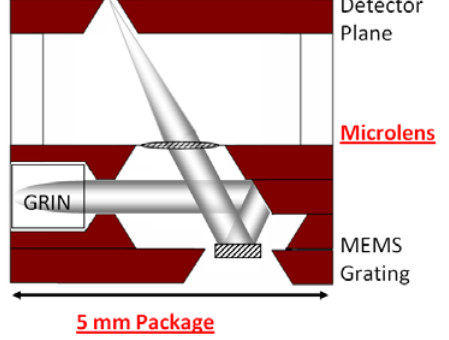
Figure 1. Cross-sectional view of the microspectrometer, showing the 5 mm silicon packaging with microlens, the MEMS grating, and other optical